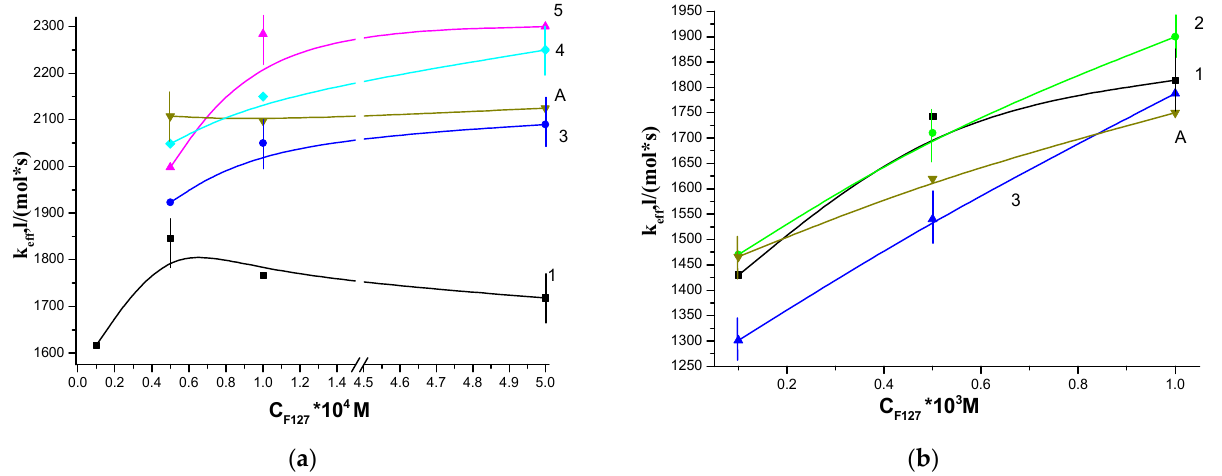
Figure 6. Dependence of the effective rate constant of tryptophan photo-oxidation catalyzed by the PS-F127-CT 100 ternary systems on the concentration of F127, where PS = TPPF20 ( a ), tetraphenylporphyrin (TPP) ( b ). Where, C CT100 = 0, C CH3COOH = 0.2% (curve A); C CT100 = 0 (curve 1); C CT100 = 10 − 4 M (curve 2); C CT100 = 6× 10 − 4 M (curve 3); C CT100 = 10 − 3 M (curve 4); C CT100 = 3× 10 − 3 M (curve 5). The concentration of porphyrin C = 5× 10 − 6 M, the concentration of tryptophan is 10 − 4 M.